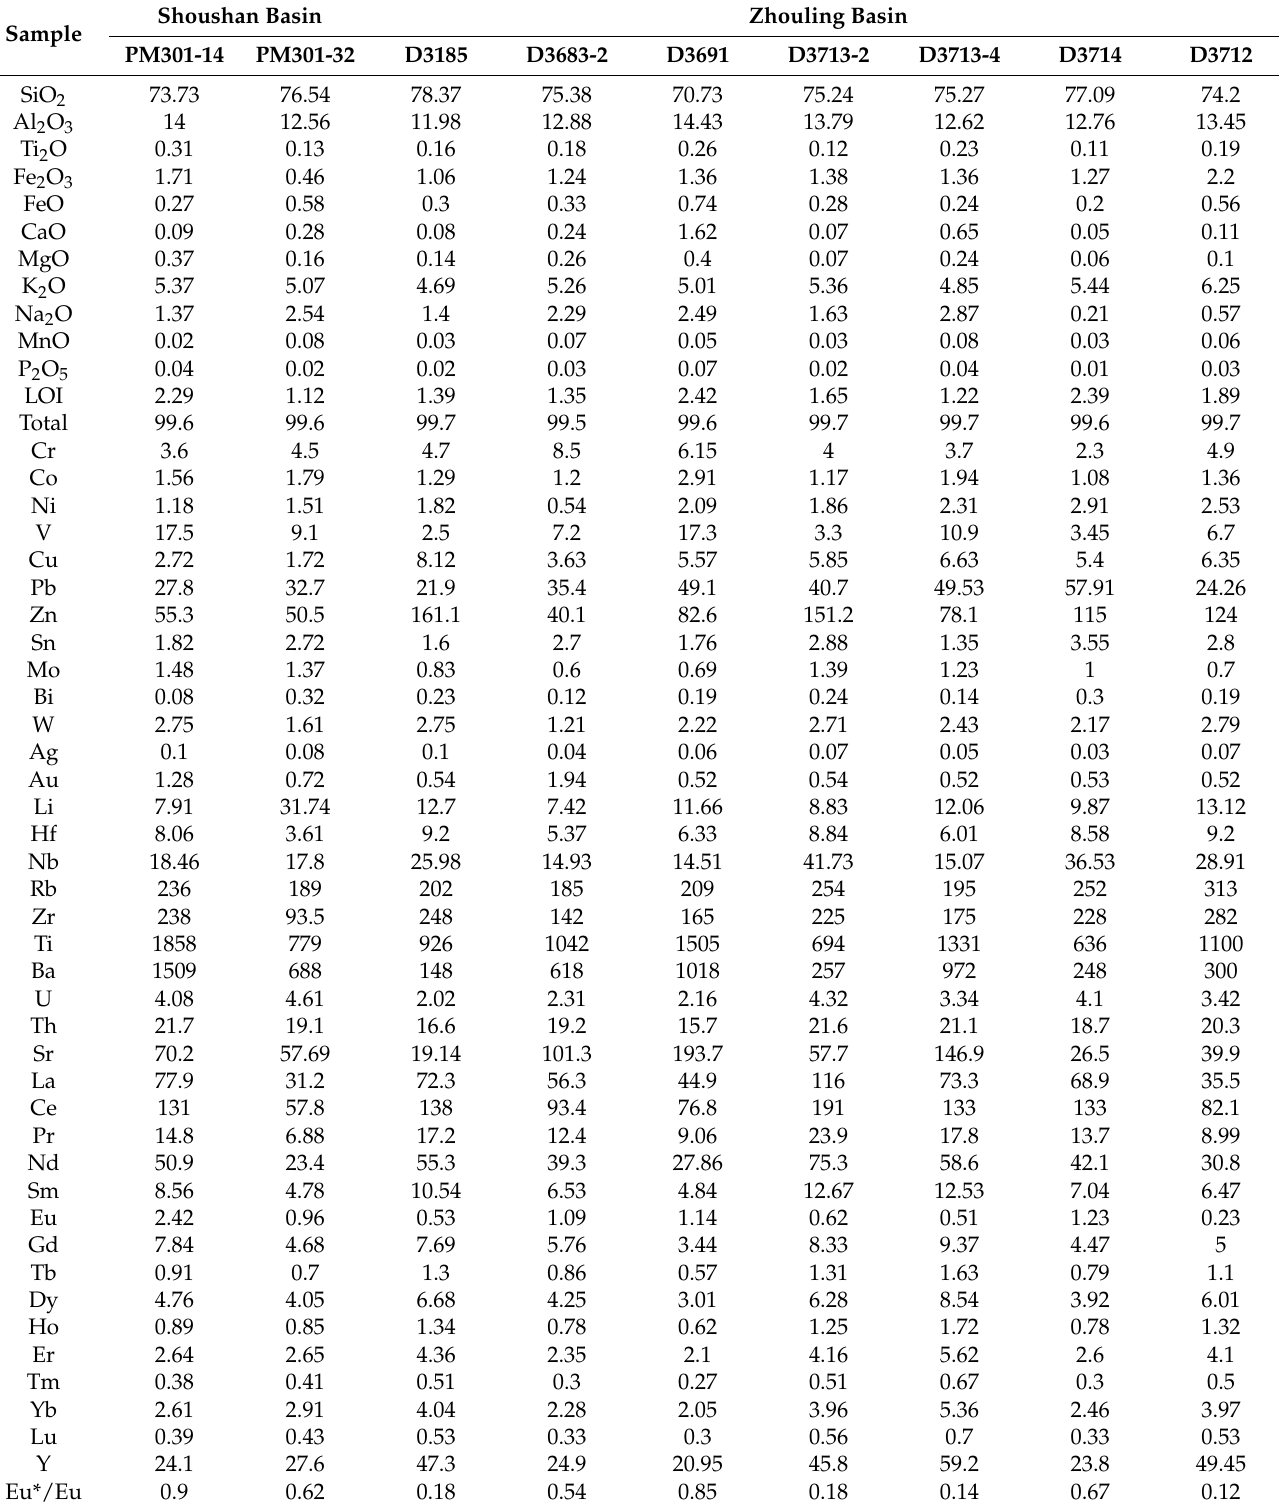
Table 3. Whole-rock major (wt. %) and trace element (ppm) compositions of rock samples from the Shoushan basin and Zhouling